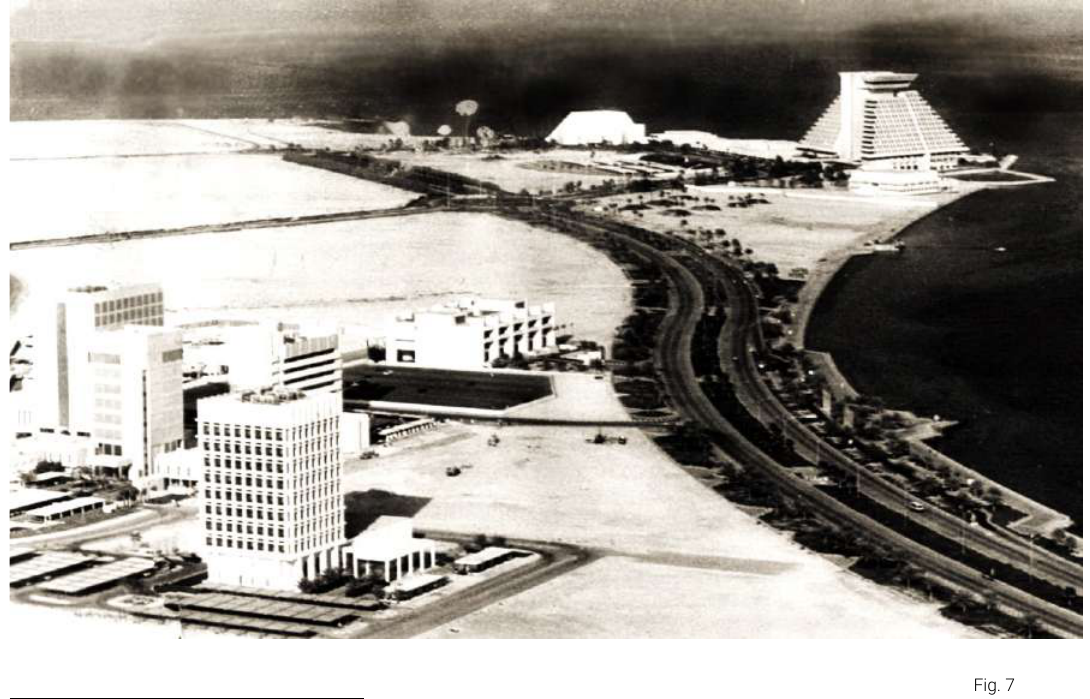
Fig. 7 Doha, QGPC in the lower left, Sheraton Hotel in the upper right, early 1980s (source: